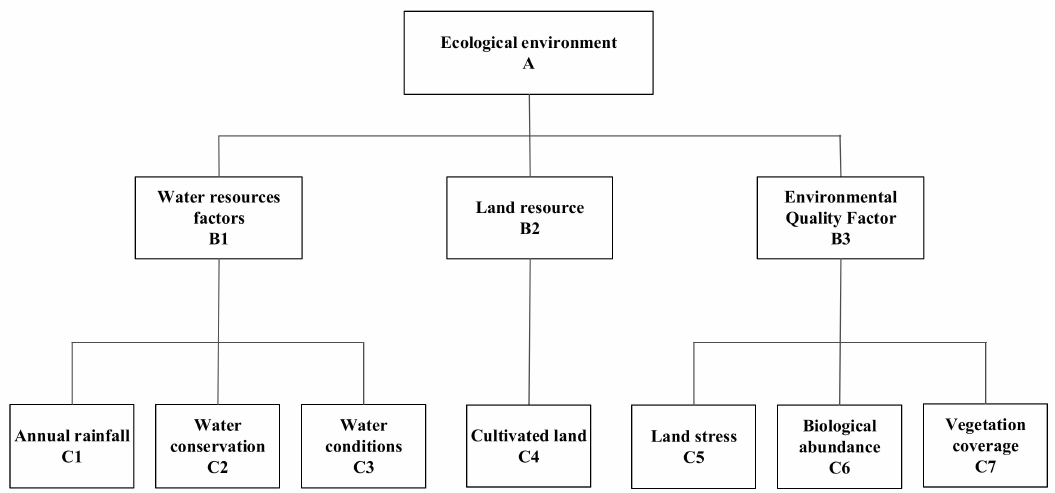
Figure 7. Hierarchical structure of ecological environment bearing capacity